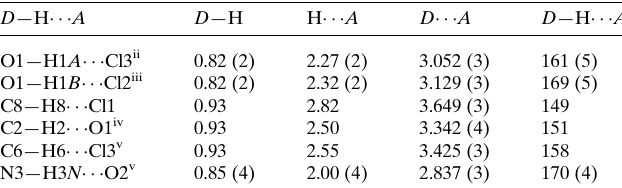
Table 2 Hydrogen-bond geometry (A˚ , (cid:3) ).